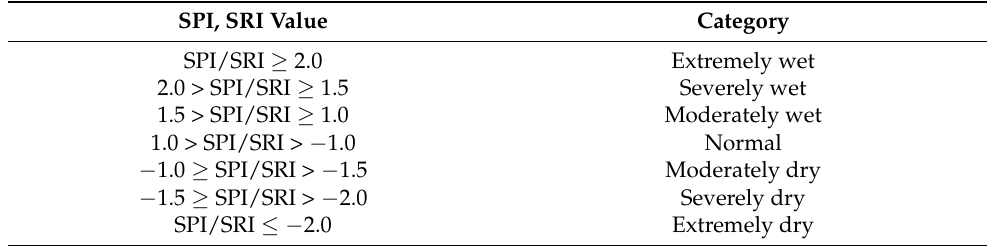
Table 3. The classification scale for SPI and SRI